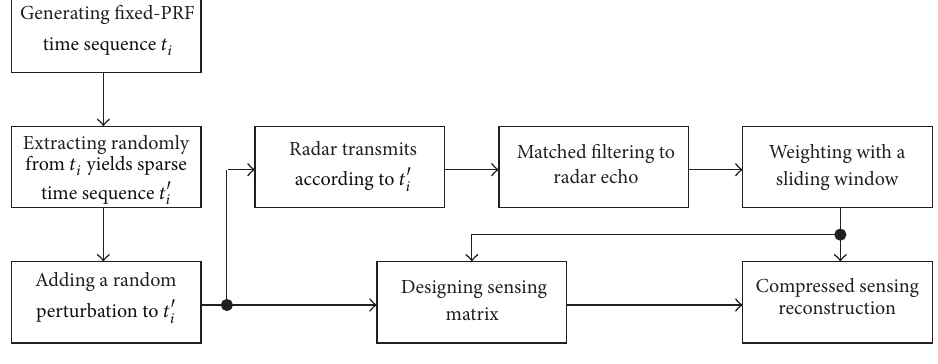
Figure 2: Flowchart of the proposed